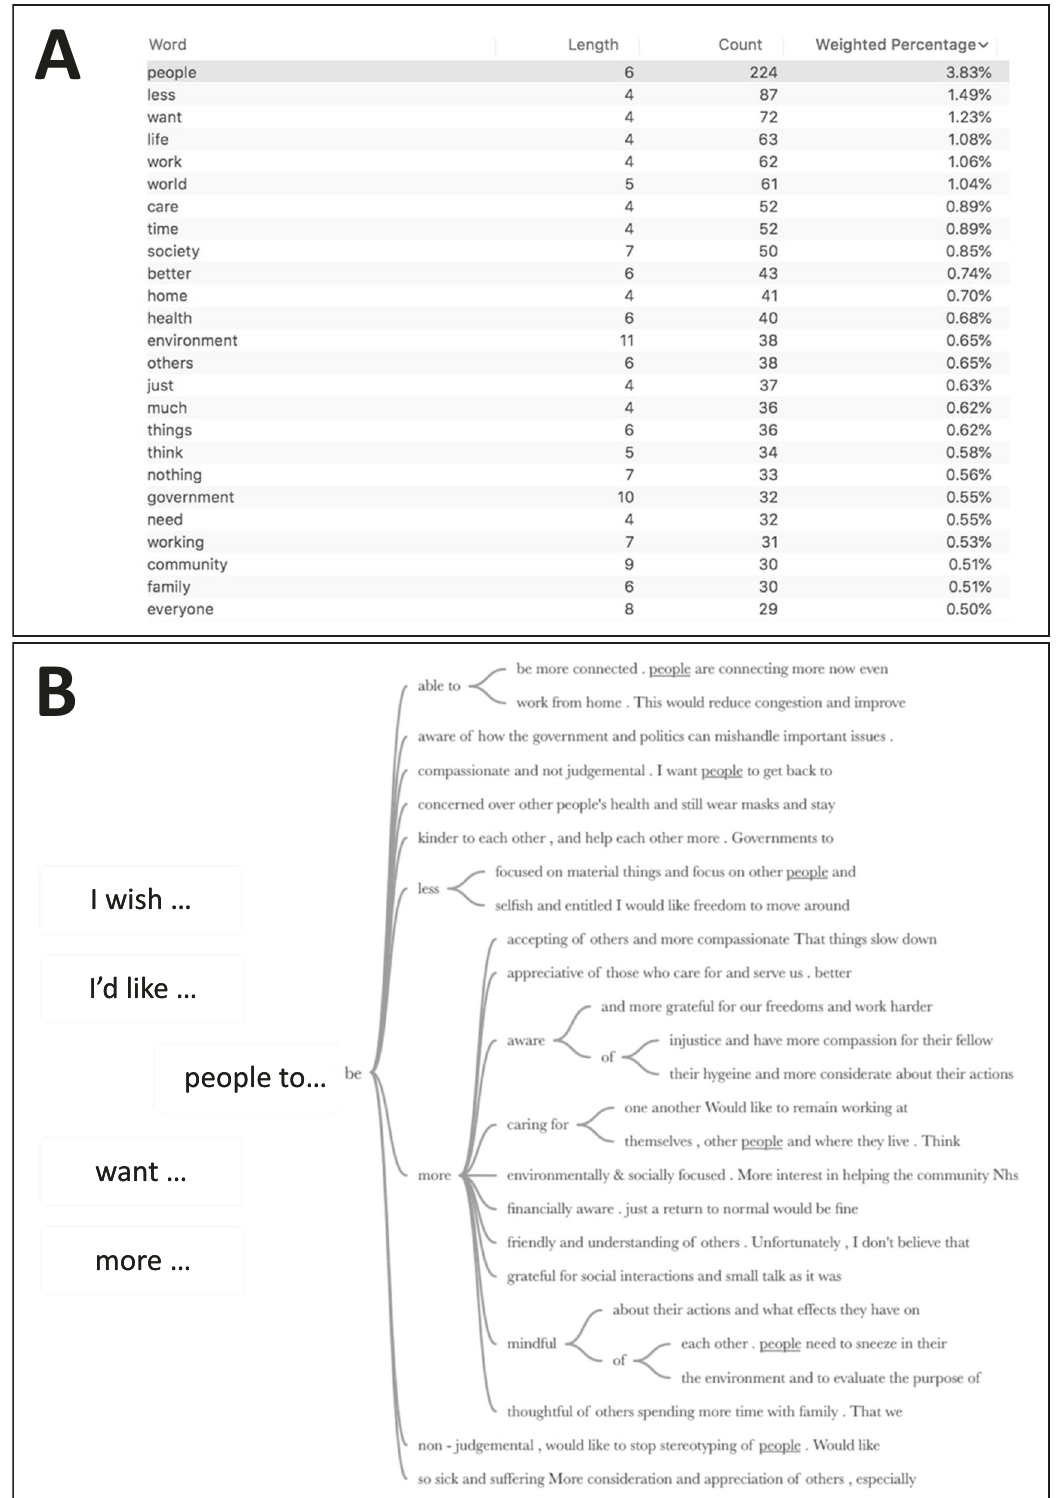
Fig. 5 Experiment 1: Responses across both samples to the fi nal open-ended question (what would you like to be different — about your life, about society, about the world — after the pandemic compared to before?). A 25 most frequent words in responses. B Partial word tree summarizing responses across both samples. See text for